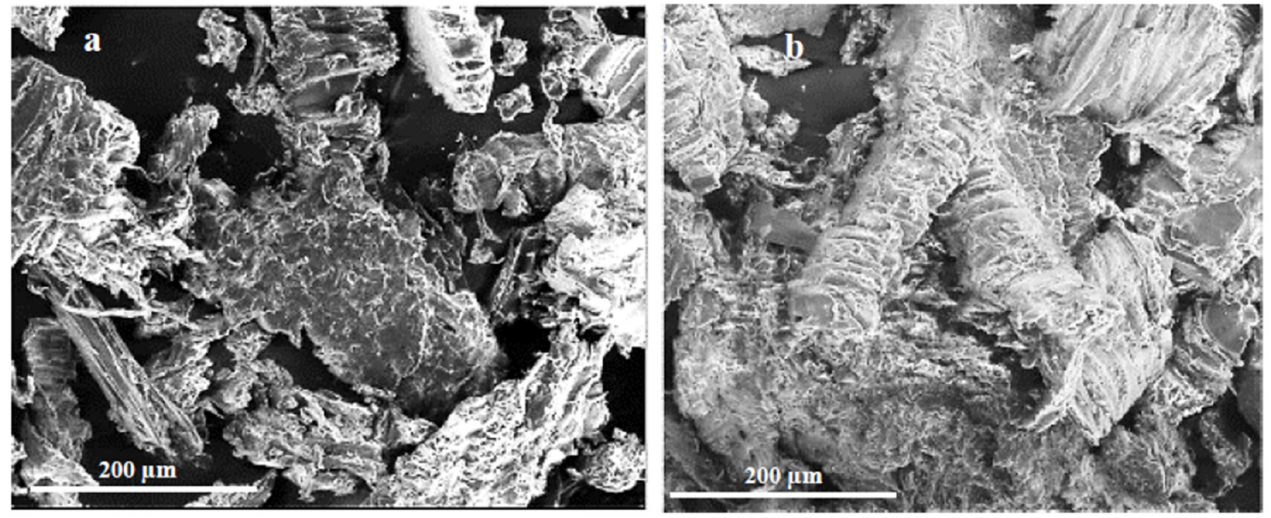
Figure 7. SEM microscopic image (magnification 350 × ) of ( a ) oak wood flour and ( b ) American walnut wood